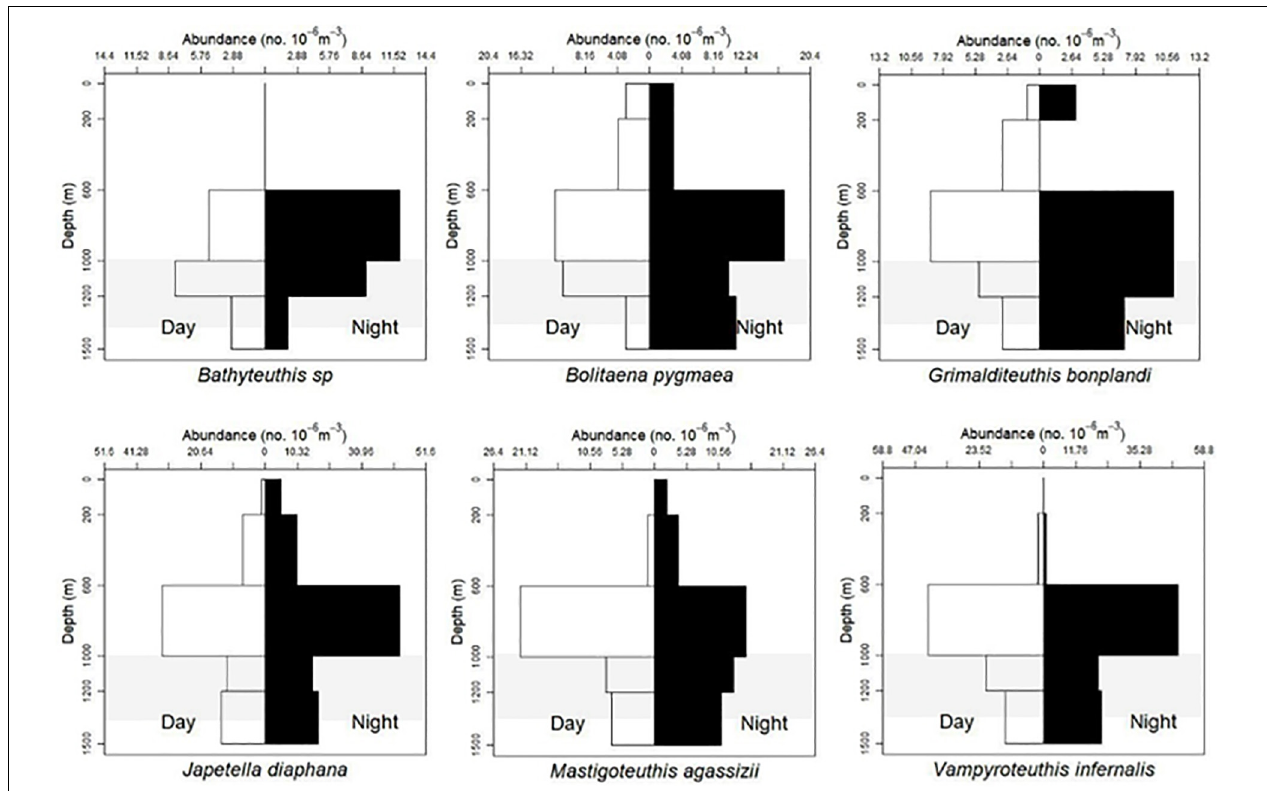
FIGURE 6 | Vertical distribution of six cephalopods. Deep-meso/bathypelagic non-migration as described by T. Sutton et al. (unpublished). Bathyteuthis sp., n = 39; B. pygmaea , n = 77; G. bonplandi , n = 53; J. diaphana , n = 153; M. agassizii , n = 82; V. infernalis , n = 157; shaded region indicates the deep oil plume zone.